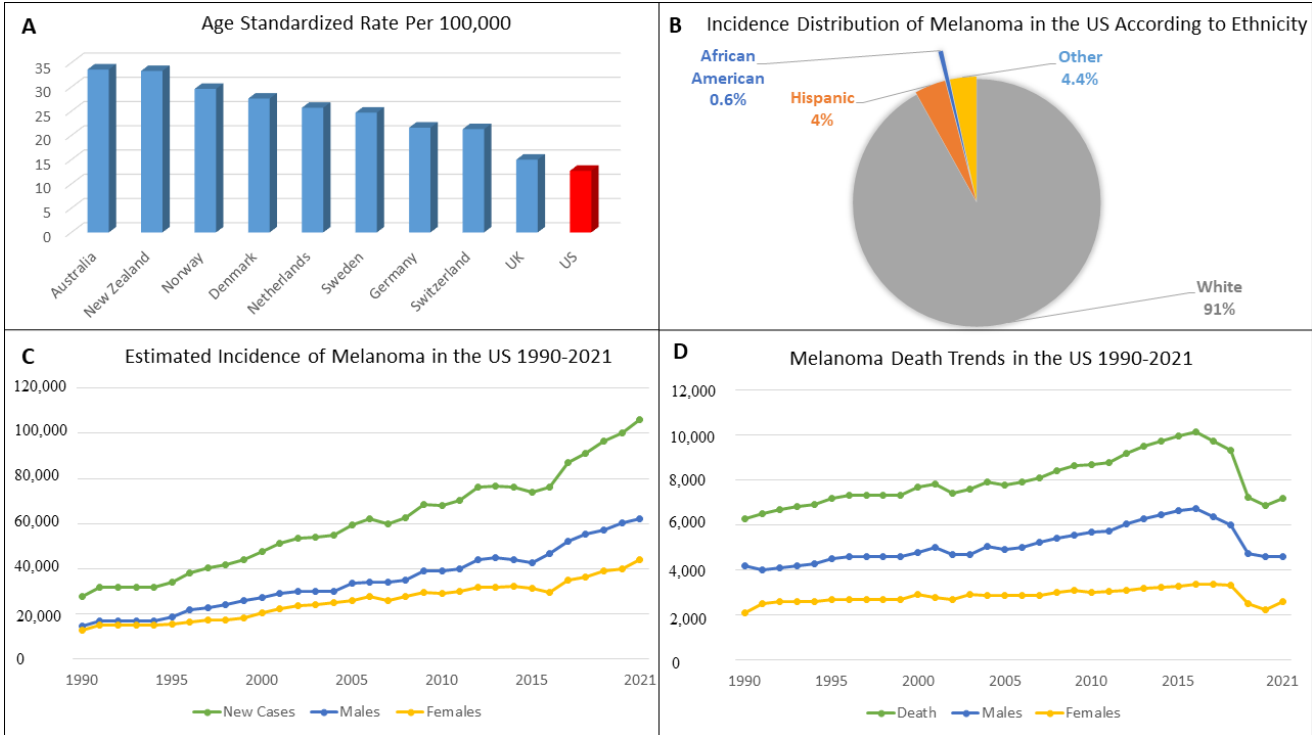
Figure 1. Epidemiology and trends of melanomas. ( A ) Age-standardized rate of melanoma cases per 100,000 in 2018 in selected countries per GLOBOCAN statistics [3]; ( B ) the 2011 incidence distribution among different ethnicities in the US [4]; ( C ) estimated incidence of melanoma cases in the US between 1990–2021 according to the American Cancer Society Statistics [6]; ( D ) estimated melanoma annual deaths in the US between 1990–2021 according to the American Cancer Society Statistics [6]. GLOBOCAN: Global Cancer Observatory.